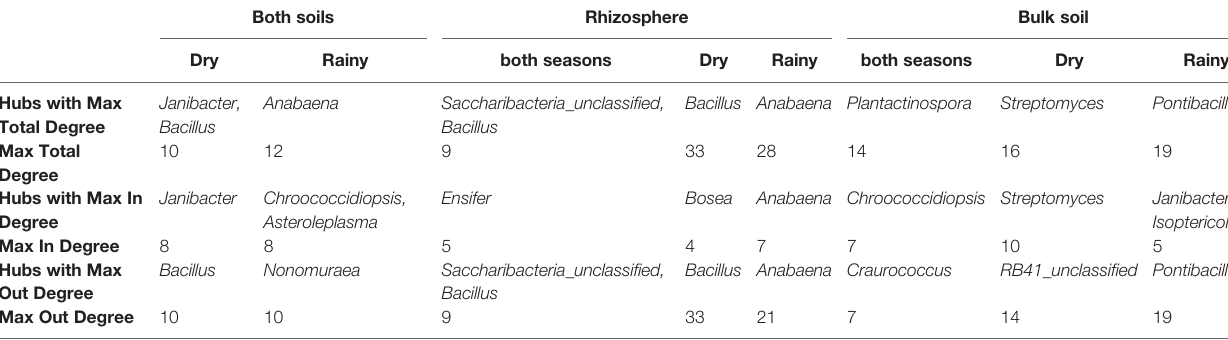
TABLE 3 | Strongly interconnected taxa or hubs identi fi ed at genus level and their number of interactions in the community networks. Both